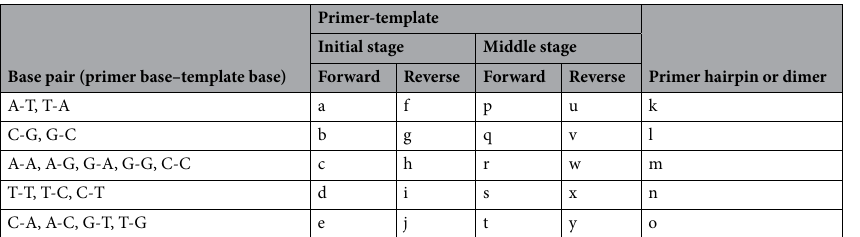
Table 3. Base pair characters for sense or antisense direction. A symbol for generating pseudo-words for RNN learning. The codes are set in the nucleotide duplex on each base pair at the complementary position. Mismatched base pairs such as A-A, T-T and C-A may appear within the partially complementary region. Base-pairs are grouped based on influence for stability of partially complementary strands.